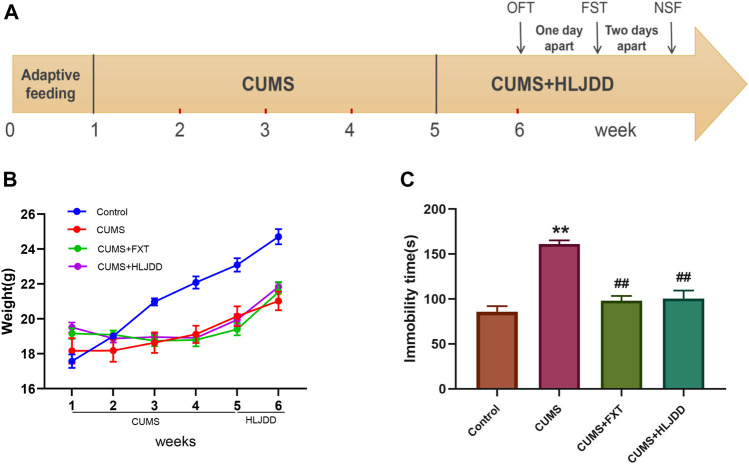
FST results showing effect of HLJDD on behavior of CUMS mice. (A) Schematic diagram of the experimental process; (B) Body weight of mice in the control group and mice in HLJDD or FXT treatment groups after six weeks (n = 10, Mean ± SEM); (C) Immobility time of mice in the control group and HLJDD or FXT treated groups after carrying out FST 1 h after treatment (n = 10, Mean ± SEM). *p < 0.05, **p < 0.01, compared with Control; ##p < 0.01, compared with CUMS via ANOVA.